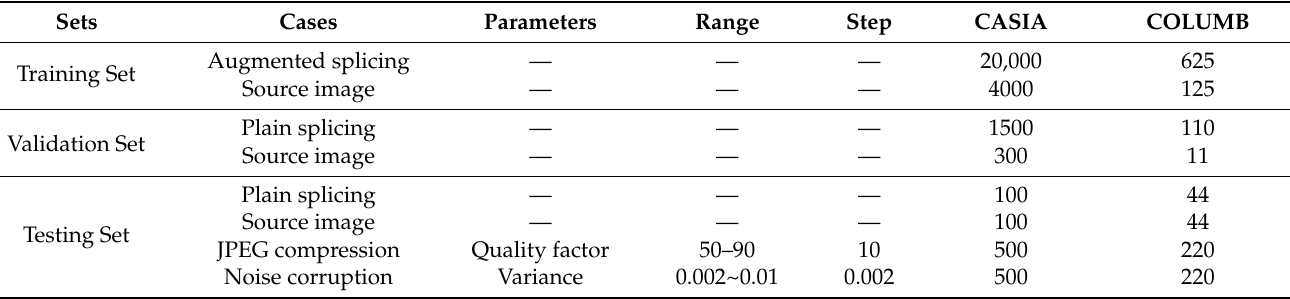
Table 2. Experiments based on CASIA and COLUMB